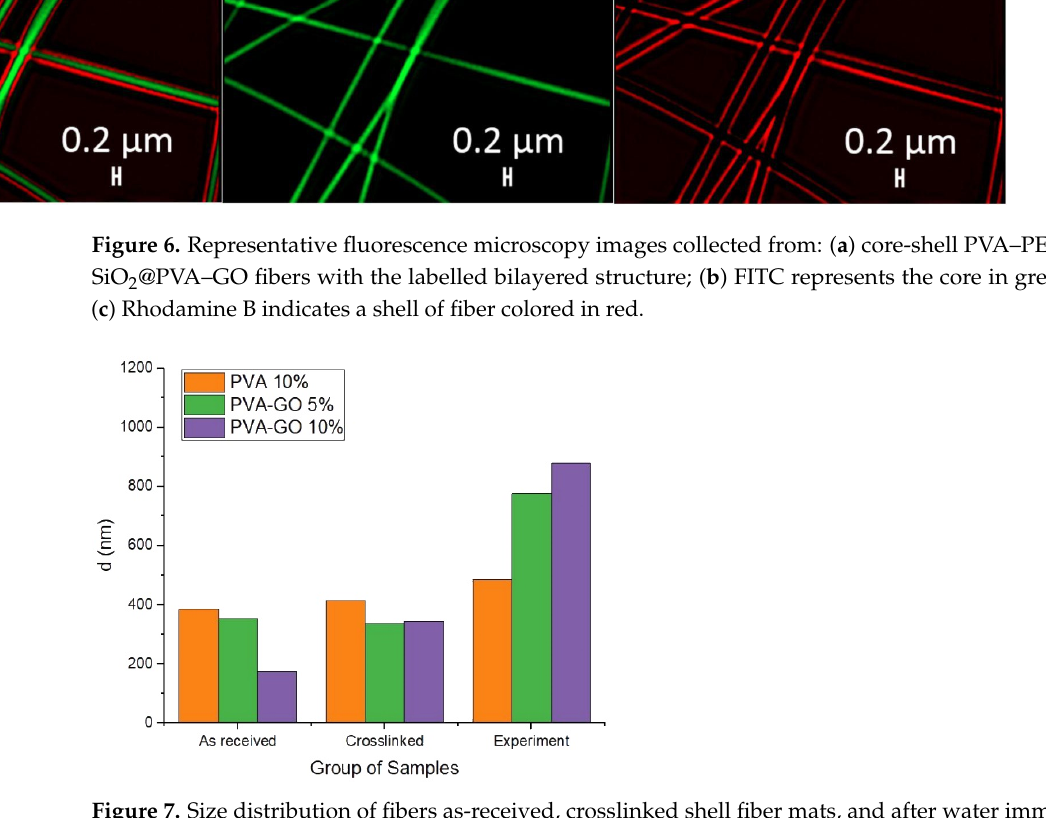
Figure 7. Size distribution of fibers as-received, crosslinked shell fiber mats, and after water immersion in 2 h.